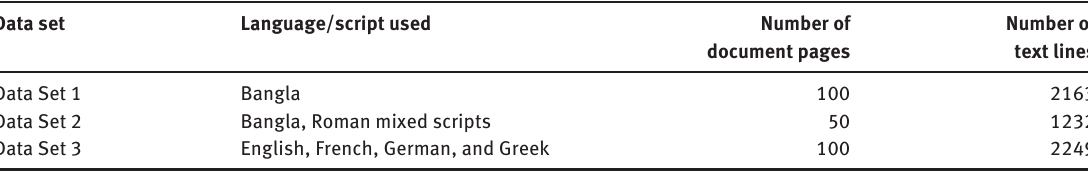
Table 1. Descriptions of the Data Sets Used for the Current